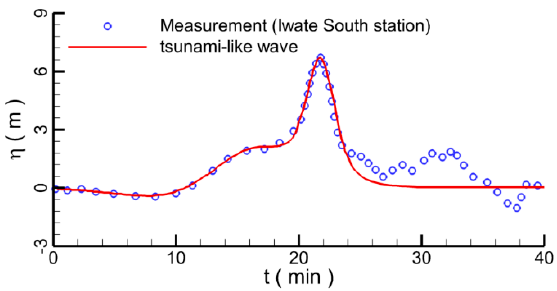
Figure 2. Comparison between the tsunami-like wave and the measured wave.